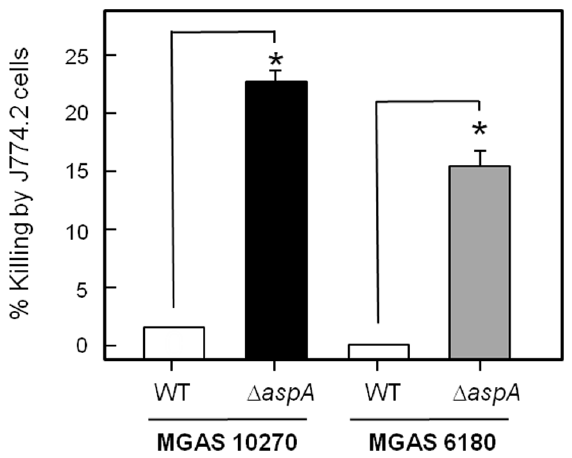
Figure 4. Numbers of bacteria (cfu) killed by macrophages (J774.2 cell line) following 1 h co-incubation with S.pyogenes MGAS6180 or MGAS10270 wild type and aspA mutants (input 5 6 10 3 cfu, 5 6 10 4 macrophages). Percentage killing was calculated from cfu remaining compared with control samples without macro- phages. Data are means 6 SEM of 3 experiments repeated in triplicate. *= P , 0.001 using 2 tail student T-test.